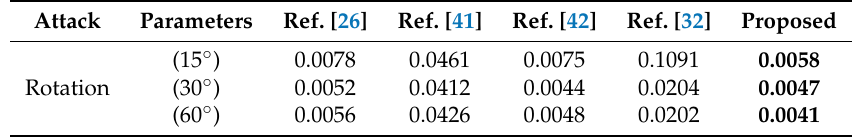
Table 5. The average BER comparison with PSNR = 42 dB under Rotation.